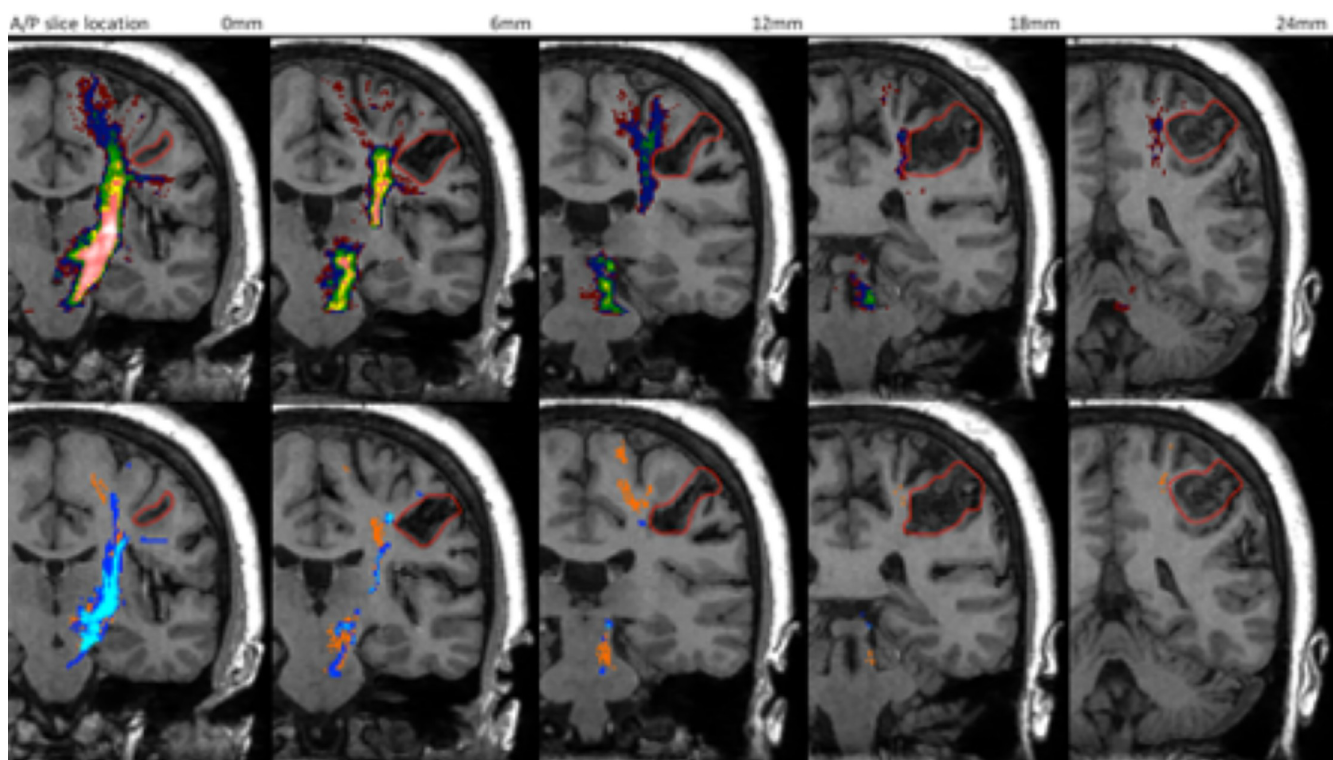
Fig 11. Tractography of the CST for patient 3. Top row: Prob 0.005 (red), Prob 0.01 (dark blue), Prob 0.025 (green), Prob 0.05 (yellow), Prob 0.075 (pink). Bottom row: CSD-stream (blue), STEALTH (orange). Lesion is outlined in red.